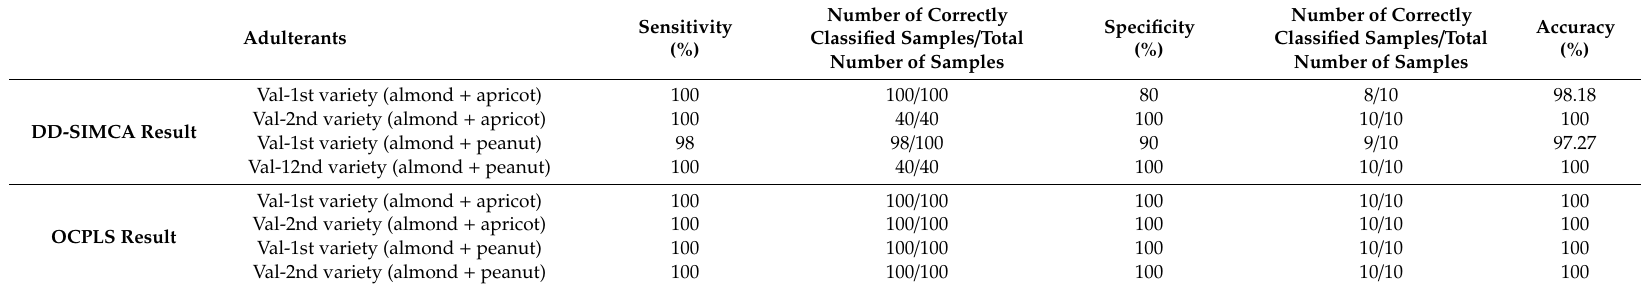
Table 2. Summary table of model performance obtained by applying OCPLS and DD-SIMCA to FT-IR data.